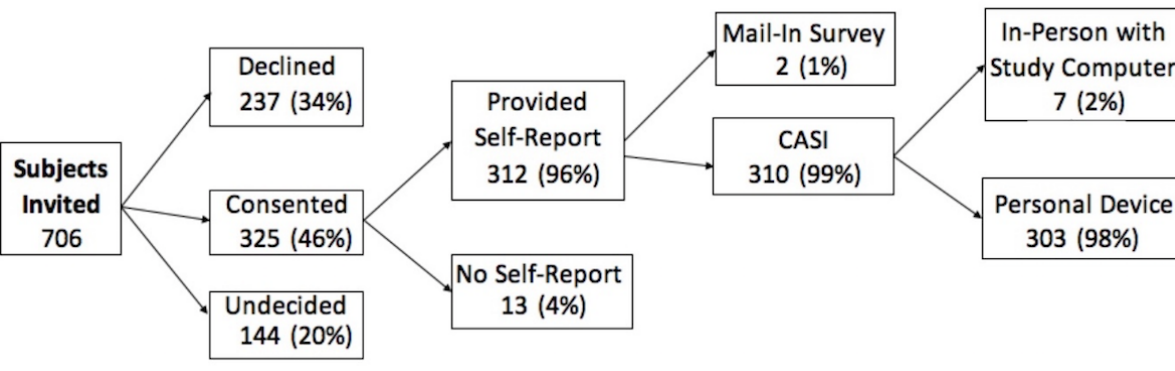
Invited to participate (N=706)Demographics